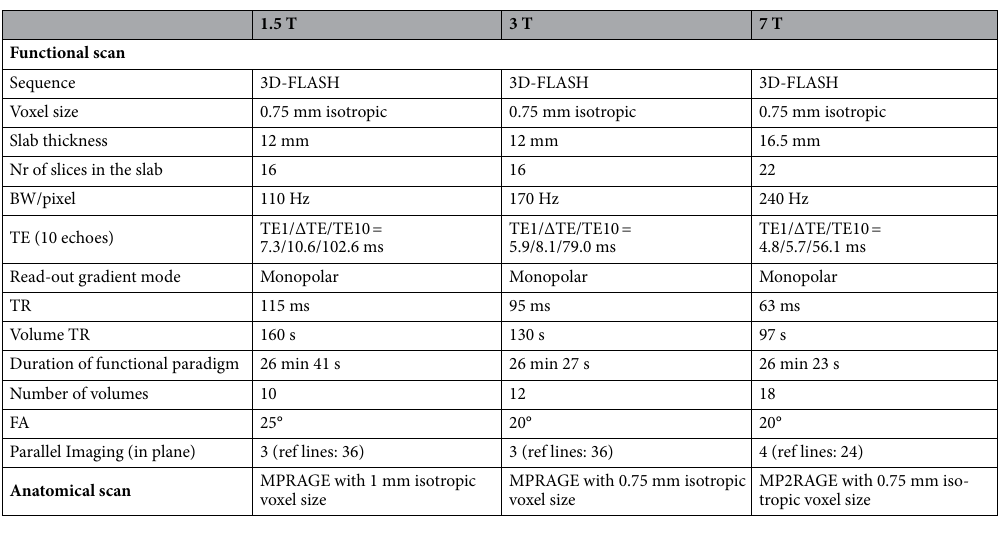
Table 1. Relevant acquisition parameters at the three studied